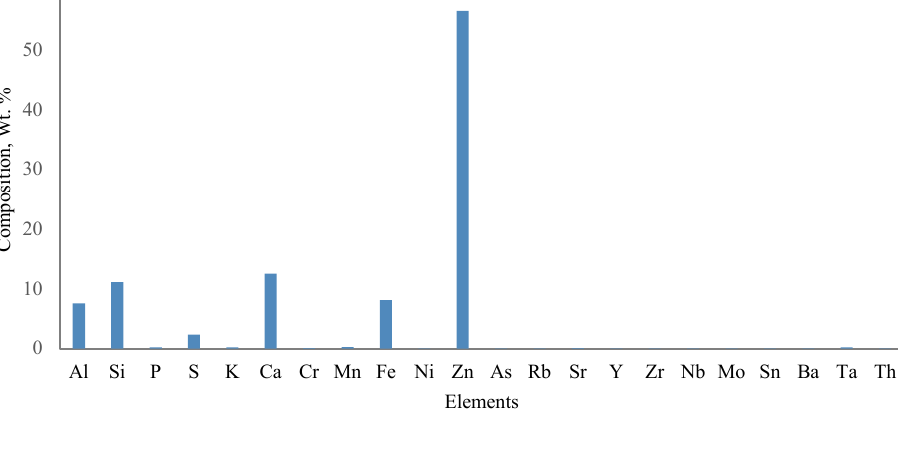
Fig. 2. Chemical composition of Modified ZnO/fly ash